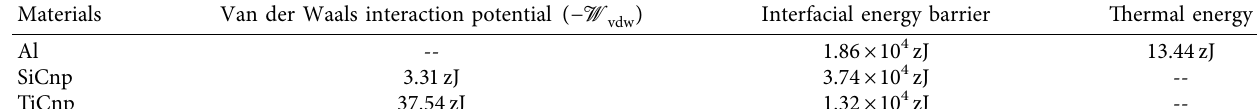
Table 3: Thermal energy and interfacial energy barrier of composites.